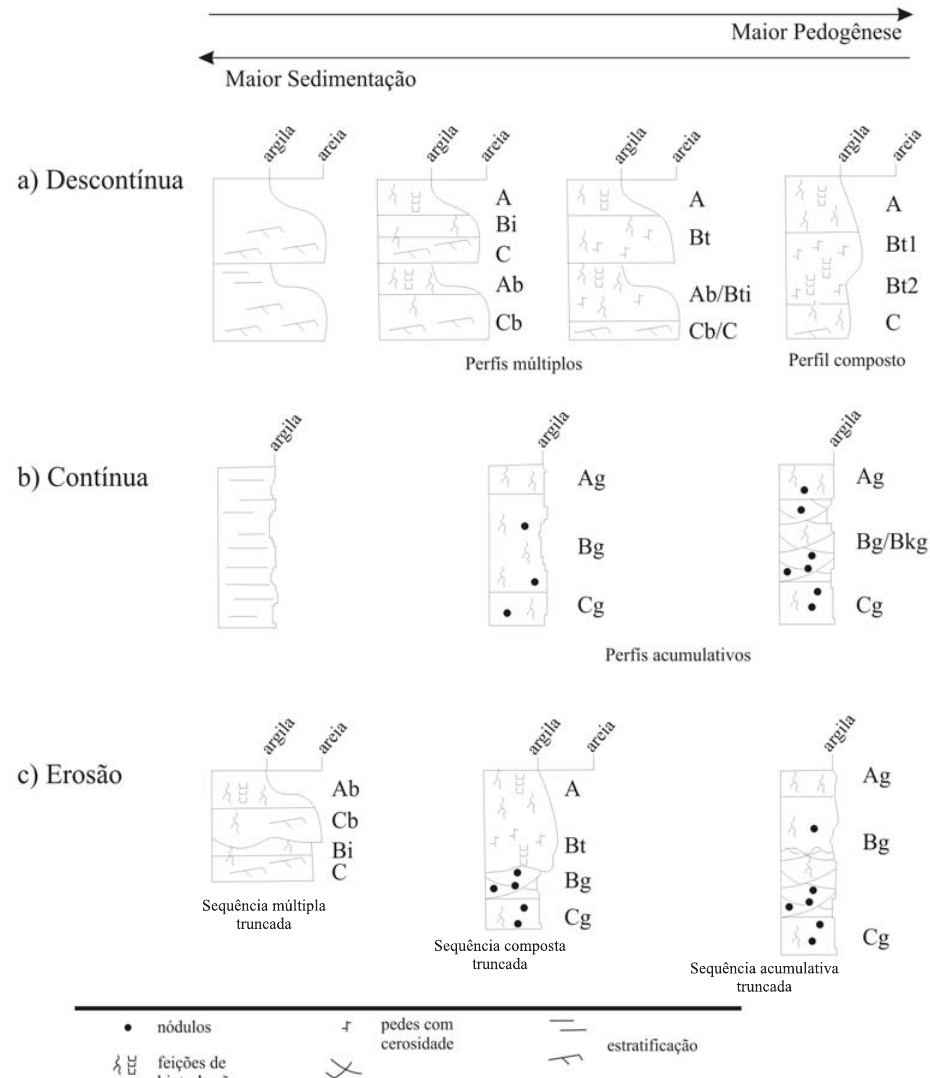
Figura 10. Perfis de sedimentos e solos (paleossolos) refletindo a variação das taxas de pedogênese e sedimentação para condições de deposição (a) descontínua e (b) contínua. Em (c) a sedimentação foi interrompida por um período de erosão. Paleossolos múltiplos predominam quando a sedimentação é descontínua. Perfis fracamente desenvolvidos se formam quando a sedimentação é contínua e rápida; perfis acumulativos são mais desenvolvidos quando as taxas de sedimentação são relativamente mais lentas que as taxas de pedogênese. Com a erosão, uma superfície ou separa dois paleossolos distintos ou é incorporada a um paleossolo em caso de longa duração da pedogênese. Fonte: Kraus